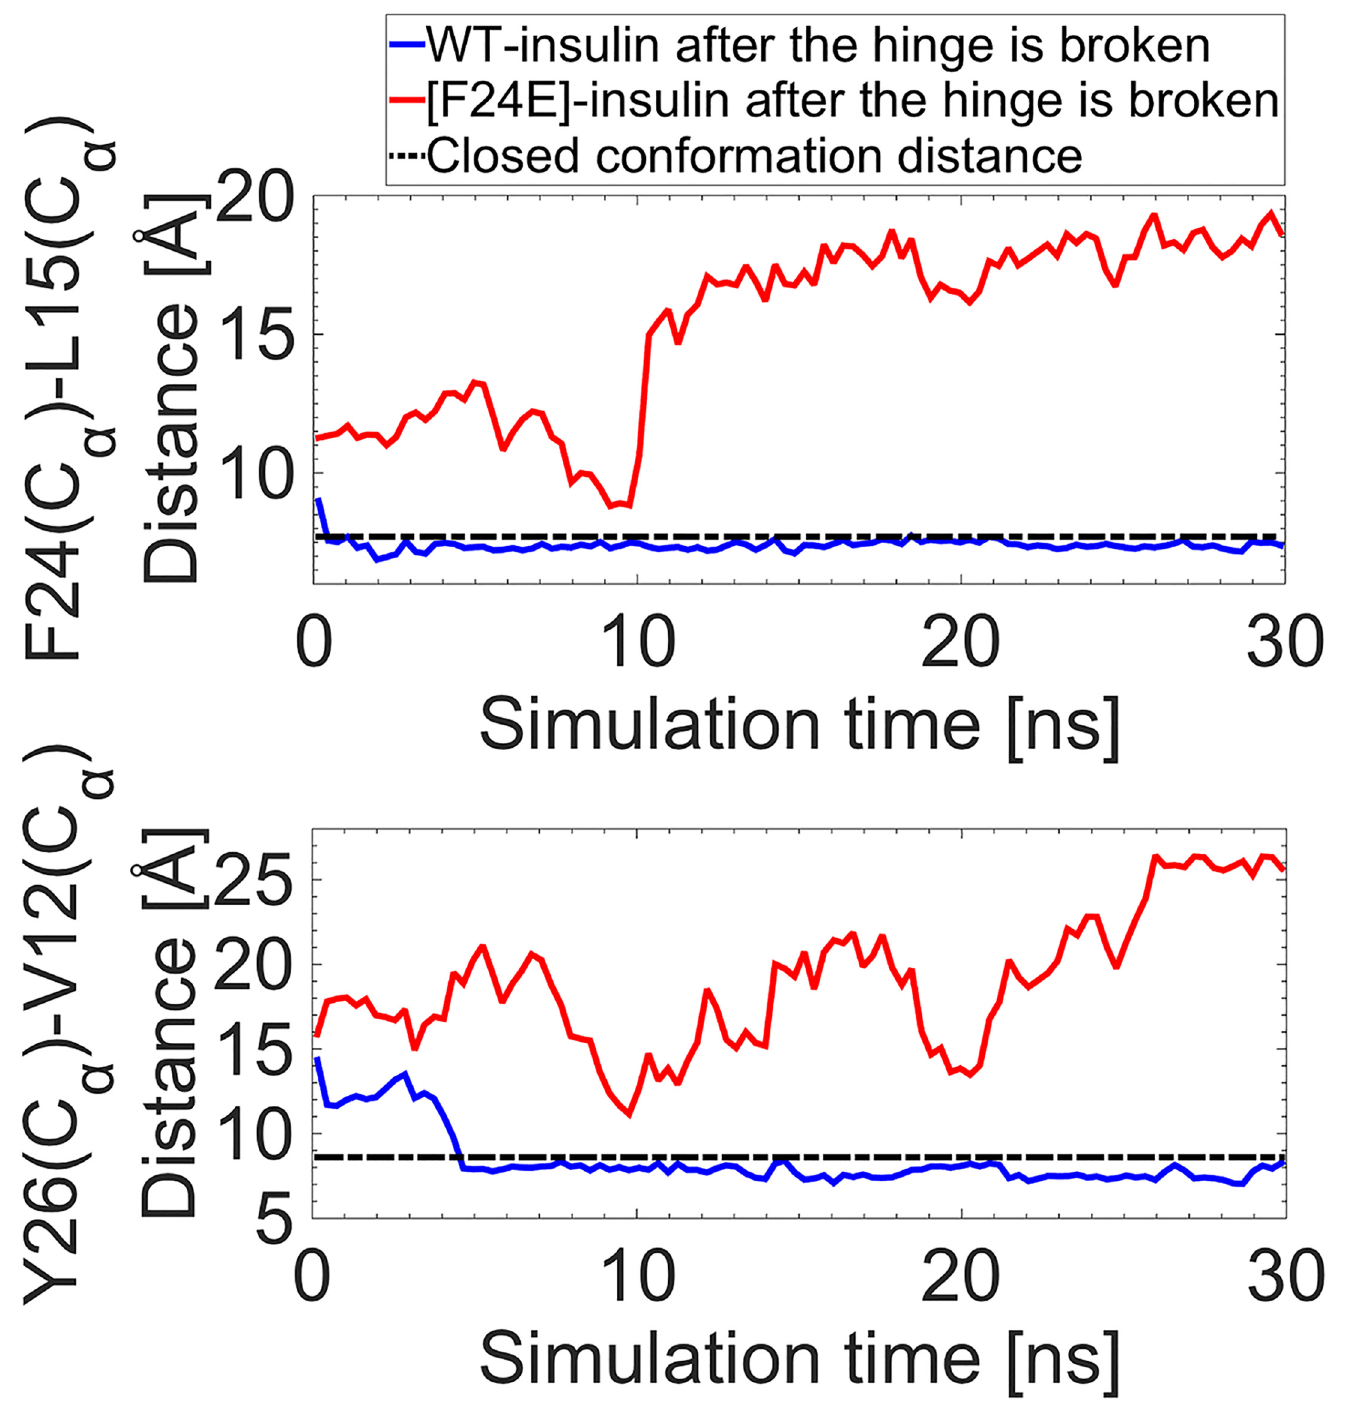
Fig 9. Stability of the hinge. Distances between the C α atoms of the F24 – L15 and Y26 – V12 pairs, which represent the hinge and the BC-CT opening, respectively, for the WT (blue) and the mutated (red) insulin, after the hinge is broken and the protein is in its wide-open conformation. The trajectories are compared to the closed conformation distance of WT insulin (black dashed